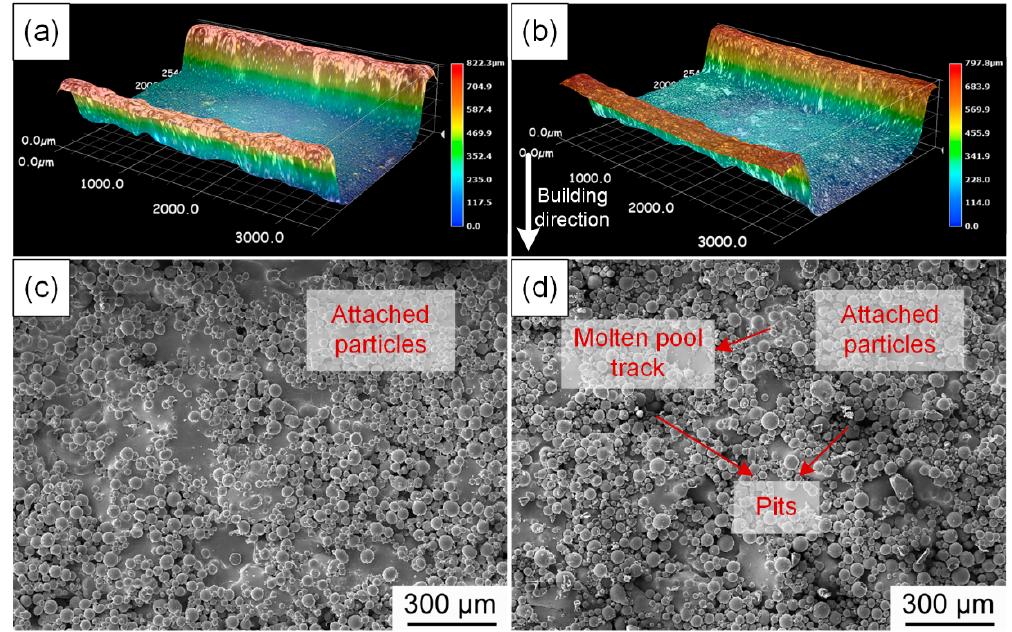
Figure 7. Morphology diagram of lower surface of sample 8-I ( a , c ) and 6-II ( b , d ).